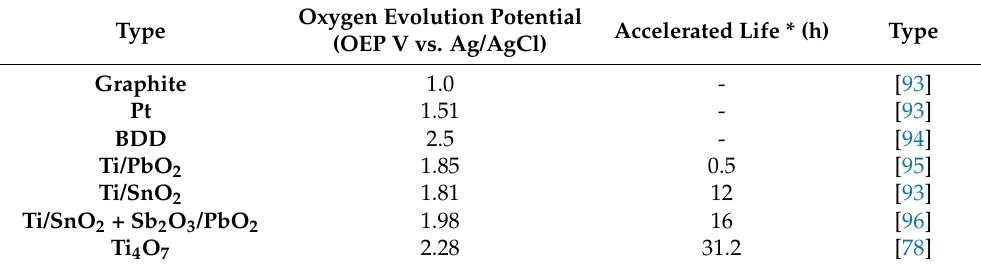
Table 4. Performance comparison of several common electrodes with Ti 4 O 7 anode.